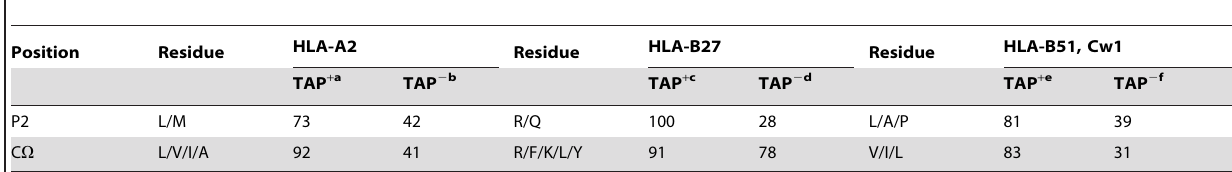
Table 1. Amino acid preference at anchor motif P2 and C V positions in TAP-dependent versus TAP-independent ligands.